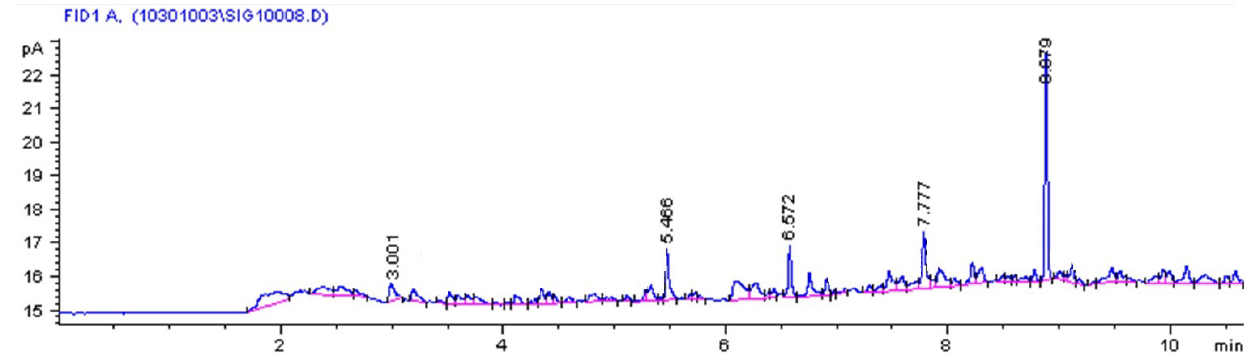
Figure 3. Main hydrocarbon analysis from combustion of incense coil. Columns , and respectively indicate the integral area extracted by 60–80 mesh, 100–120 mesh NTS and SPME fibers via GC-GID analysis.